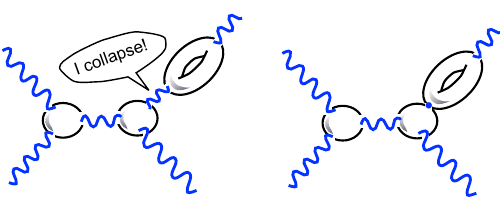
Figure 3 . Collapse of speci(cid:12)c propagator avoids double factorization limit.